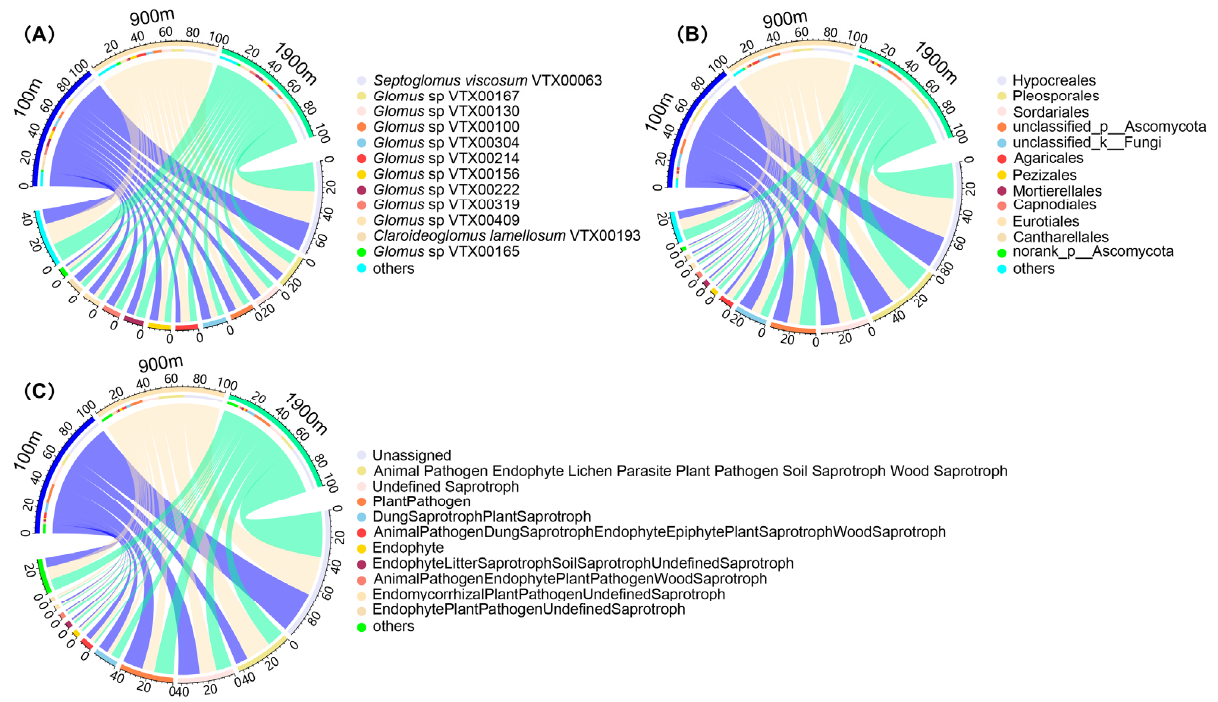
Figure 1. Proportion and function of AMF and soil fungal communities. ( A ): Soil AMF community composition, ( B ): Soil fungal community composition, ( C ): Soil fungal community function.